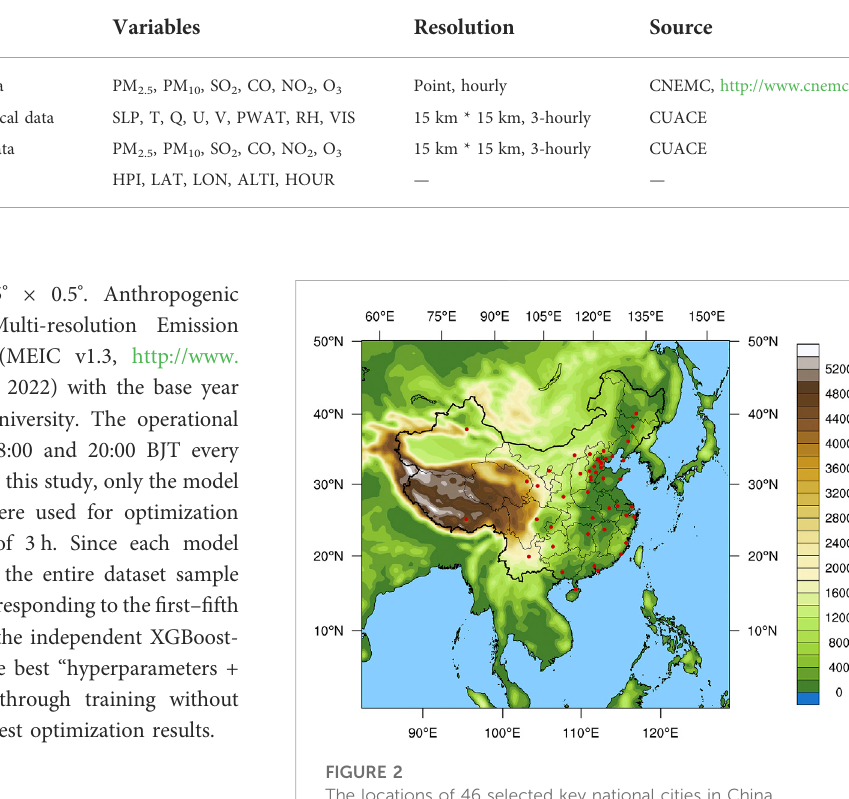
FIGURE 2 The locations of 46 selected key national cities in